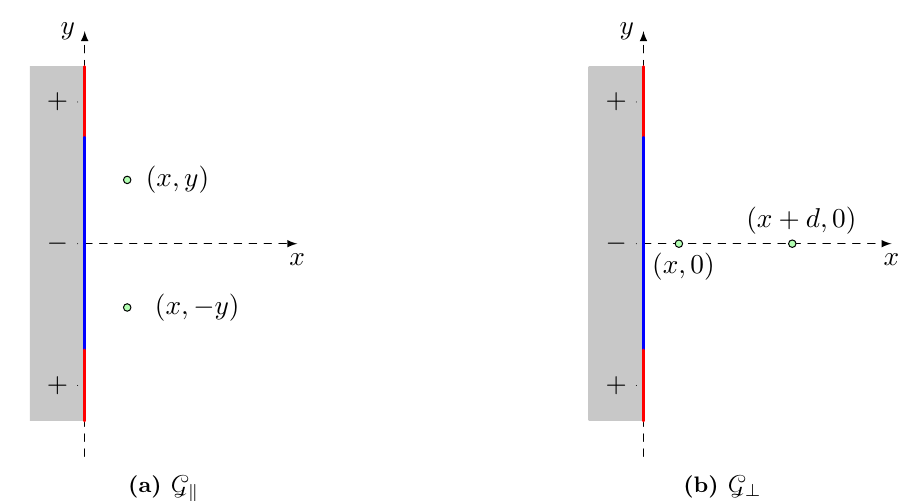
Figure 5. Definition of parallel (a) and perpendicular (b) correlation function for the Ising